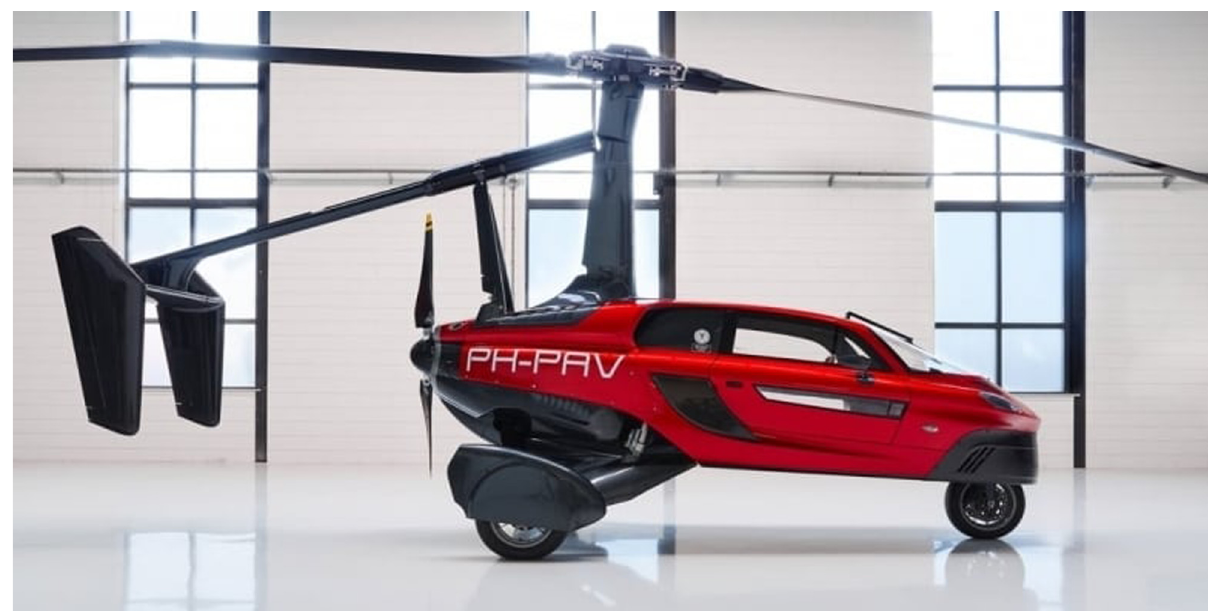
Figure 6: PAL - V Liberty Sport from outside with extended rotor and propeller ( image credit: PAL - V International B.V., used with permission ) .